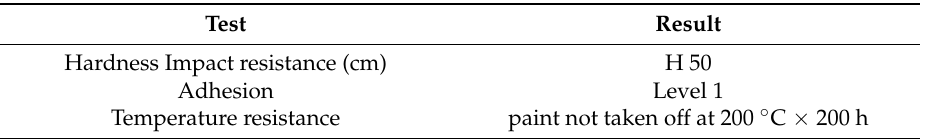
Table 3. The performance test results of the coating.